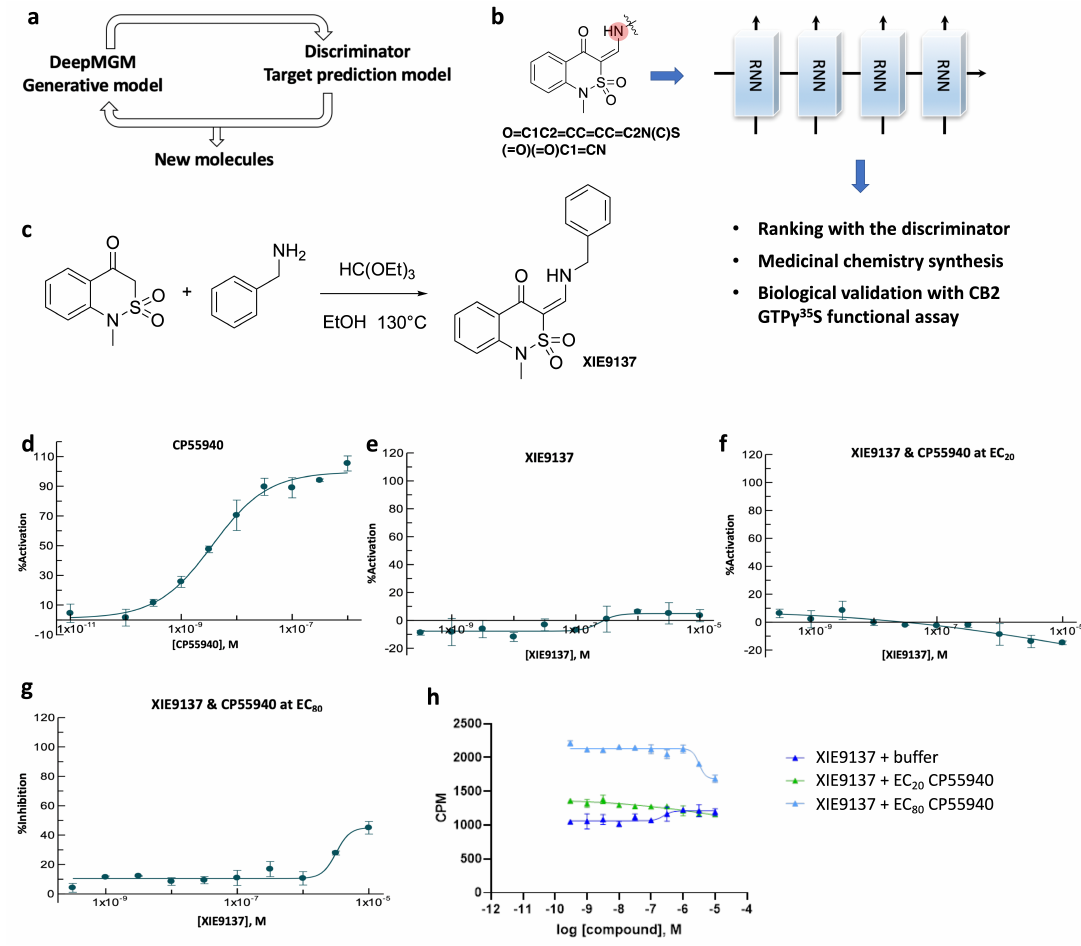
Figure 6. Identification of XIE9137 as a potential negative allosteric modulator for CB2. ( a ) Scheme of the in silico design-test circle. ( b ) Using chemistry synthesis and biological validation to eval- uate generated molecules by the t-DeepMGM. ( c ) Synthetic route to obtain the target compound. ( d , e ) CB2 [ 35 S]-GTP γ S functional assay for CP55940 ( d ) and XIE9137 ( e ) alone. ( f , g ) CB2 [ 35 S]-GTP γ S functional assay for XIE9137 with the coexistence of CP55940 at EC 20 concentration ( f ) and EC 80 concentration ( g ). ( h ) Counts per minute in the CB2 [ 35 S]-GTP γ S functional assay for XIE9137 at different log